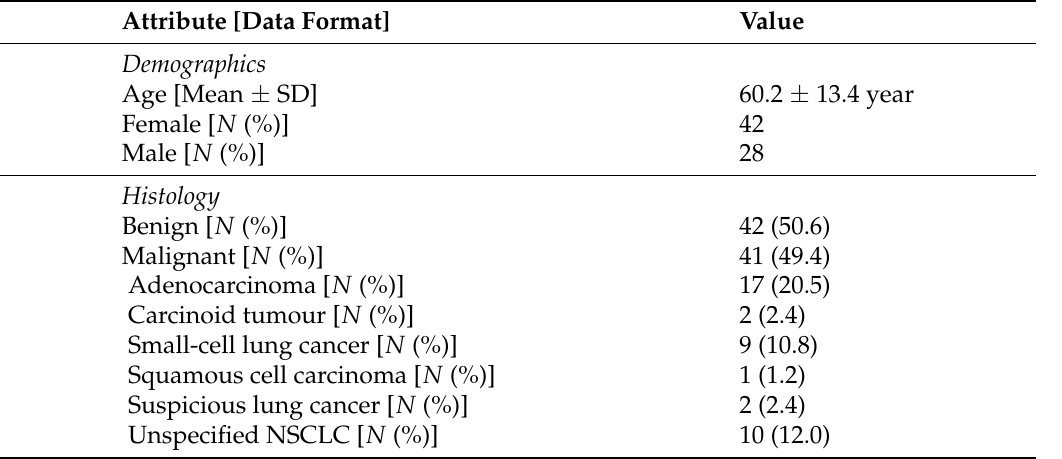
Table 2. Dataset LUNGx: Characteristics of the patient